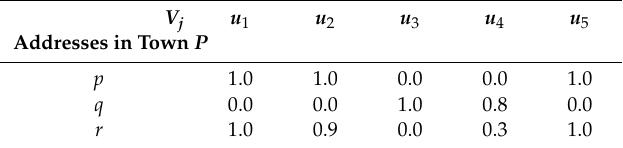
Table 1. Attribute value appurtenance fuzzy degree function for j ∈ A on Town P ( d j ).